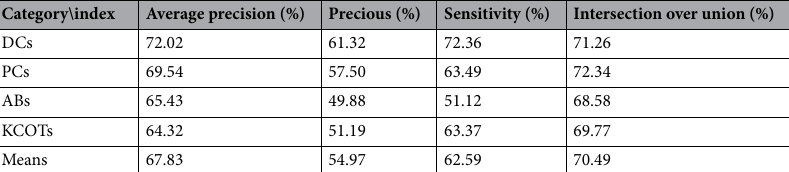
Table 4. The detection performance of different cysts and tumors. Cysts (DCs and PCs) have better detection performance than tumors (ABs and KCOTs), which is consistent with the classification performance in Table 1 that cysts (DCs and PCs) achieve higher sensitivity/recall scores than tumors (ABs and KCOTs).